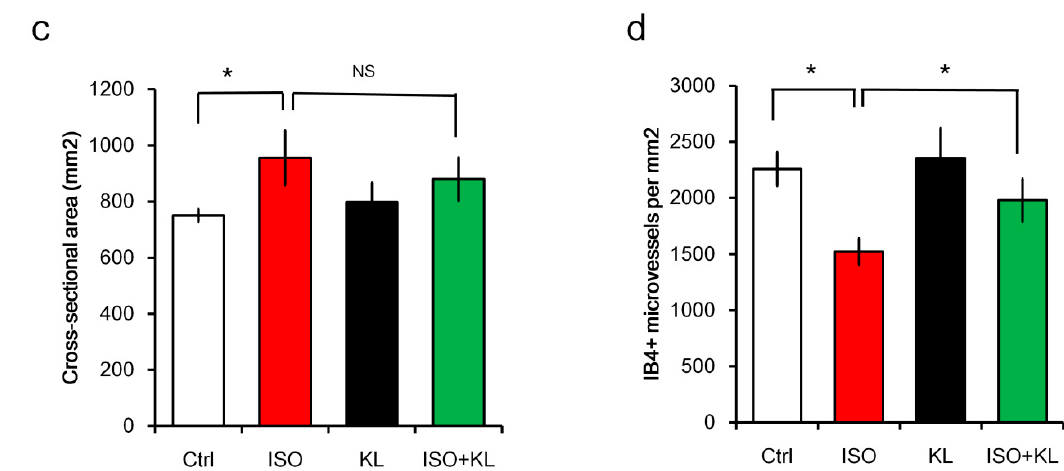
Figure 2. KL inhibited isoproterenol-induced cardiac damage in vivo. Balb / c mice ( n = 10 in each group) were treated with saline control (Ctrl, normal saline in 100 µ L, s.c.), isoproterenol (ISO) (60 mg / kg / day for 3 days, s.c.), KL (0.5 µ g / mice / days for 5 days, i.p.), or ISO plus KL for 3 days. Mice were sacrificed, and their hearts were collected for Masson’s Trichrome staining for tissue fibrosis ( a ), and for measurements of fibrosis area ( b ), and cardiomyocyte cross-sectional area ( c ). ( d ) Quantification of isolectin B4-stained microvessels. * indicates p < 0.05. Bars represent 1000 µ m and 50 µ m in the upper and lower panel of Figure 2a, respectively.